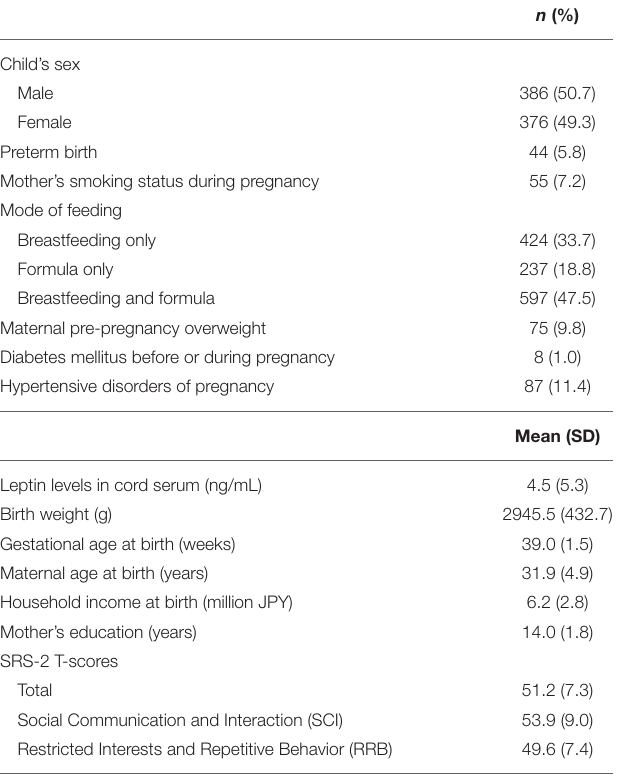
TABLE 3 | Estimated coefficients and p -values in Model 2.